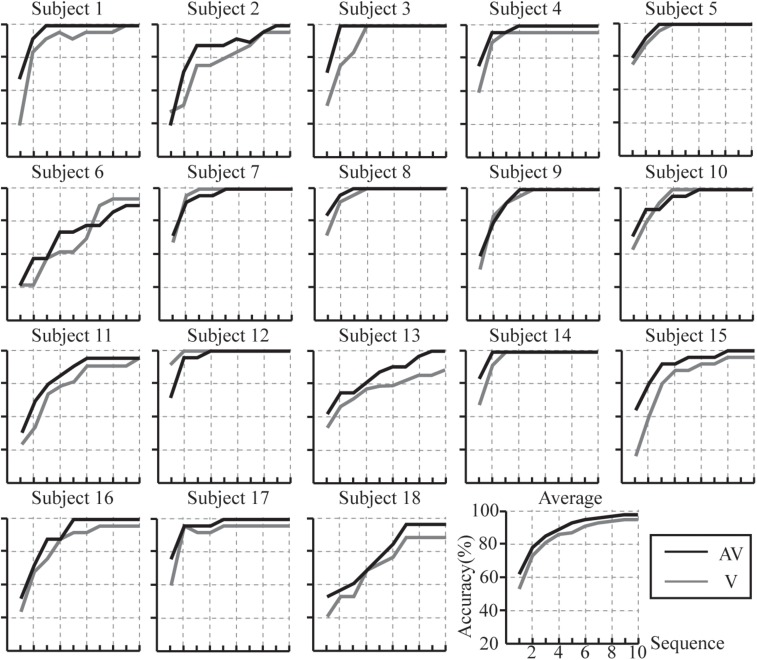
Individual and average accuracies of the P300-speller system with V and AV spelling paradigms for the 18 subjects.